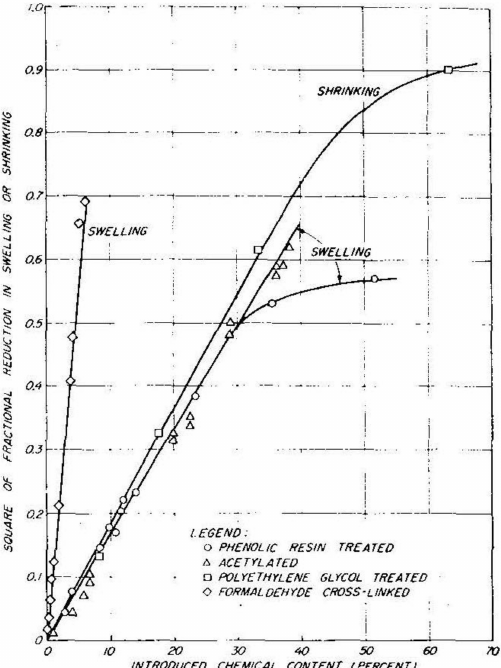
Figure 7. Relationship between the square of the fractional reduction in swelling or shrinking and the chemical content of Sitka spruce when acetylated, treated with phenolic resin or polyethylene glycol, or crosslinked with formaldehyde [14].